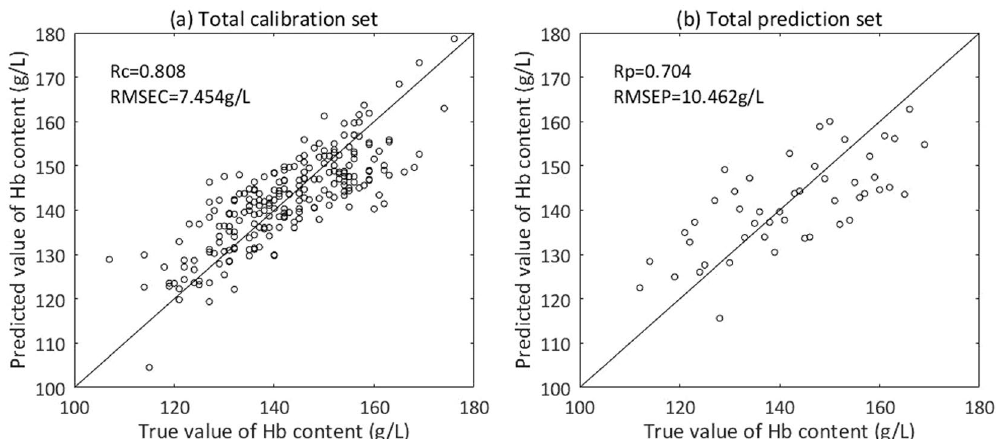
Figure 8. Scatter plot of true value and predicted value of Hb content by non-grouping modeling. ( a ) Total calibration set. ( b ) Total prediction